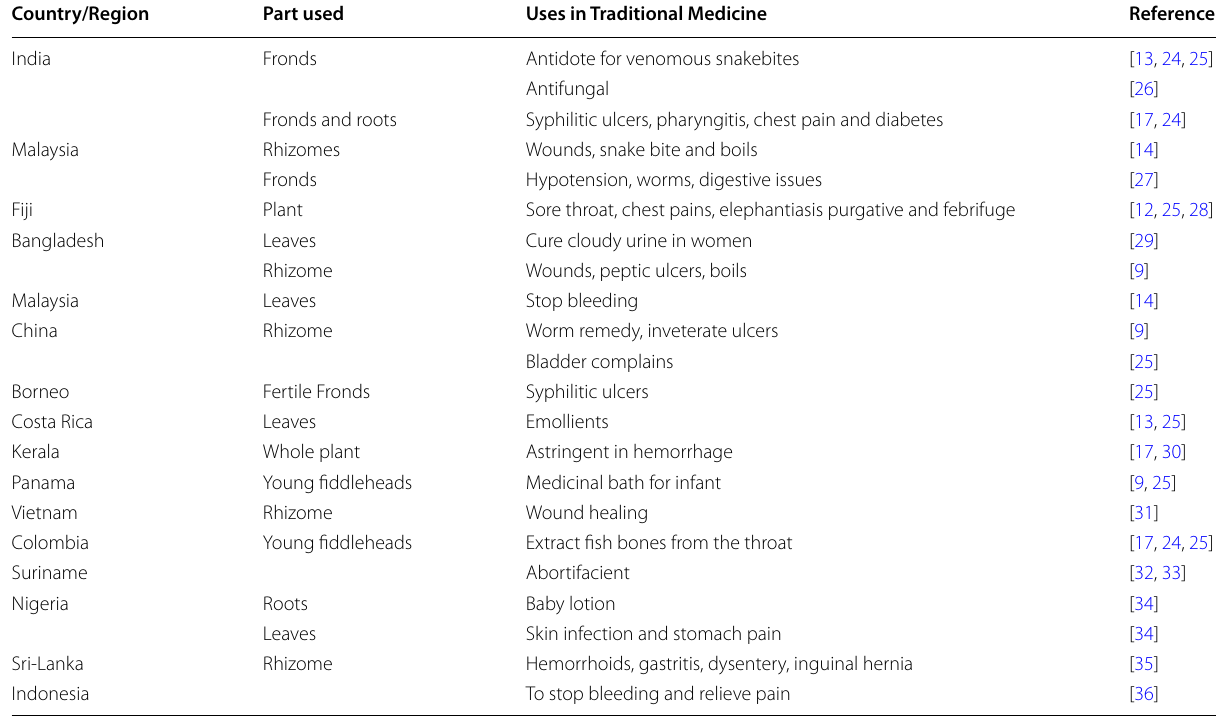
Table 2 Traditional medicinal uses of Acrostichum aureum